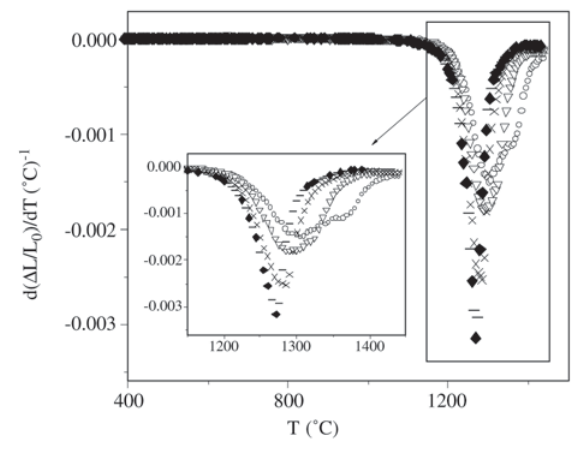
Figure 1. XRD patterns of SnO 1300 °C for 4 h. a) SMNb0.05%; b) SMNb0.10%; c) SMNb0.15%; d) SMNb0.20%.